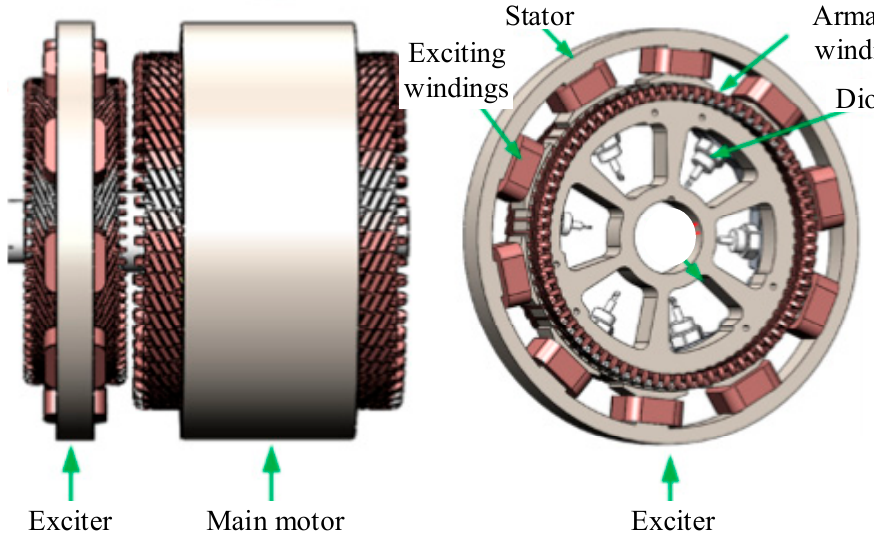
Figure 1. The two-stage structure of the proposed WFSM.